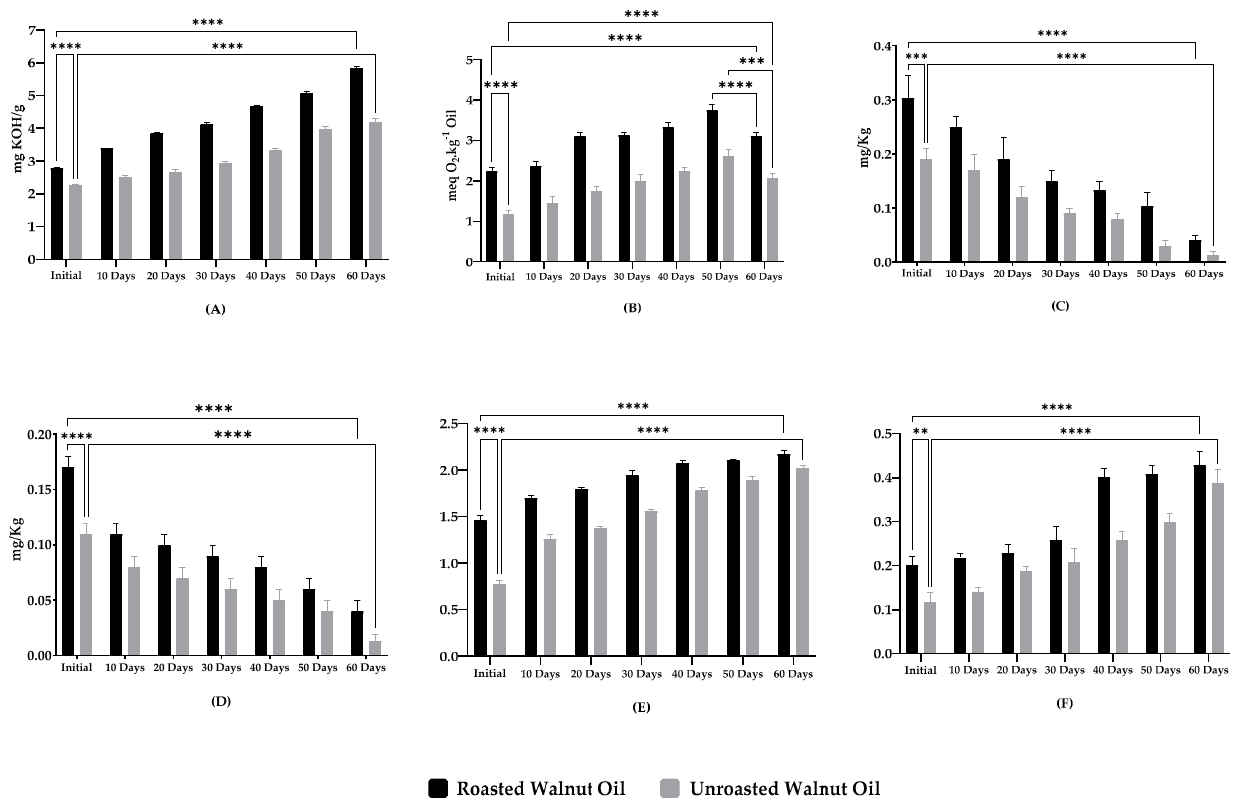
Figure 1. The physicochemical quality parameters, chlorophyll, and carotenoid content. ( A ) Evolution of acid value (mg KOH/g oil) during 60 days; ( B ) Evolution of peroxide value (meq O 2 · kg -1 oil) during 60 days; ( C ) Evolution of chlorophyll content (mg/kg) during 60 days; ( D ) Evolution of carotenoids content (mg/kg) during 60 days; ( E ) Evolution of K 232 during 60 days; ( F ) Evolution of K 270 during 60 days. ** (0.001 < p < 0.01); *** (0.0001 < p < 0.001); **** ( p < 0.0001).